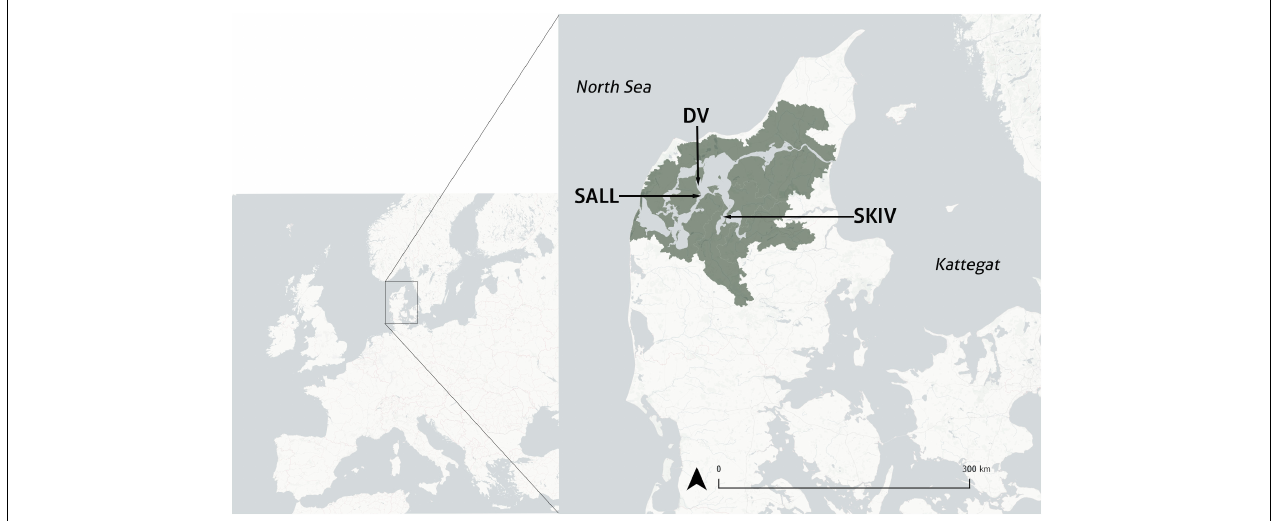
FIGURE 1 | Map of mainland Denmark and location of three study sites, inset to a map of Europe. Limfjorden catchment is illustrated in dark gray. SKIV, Skive Fjord site; DV, Dråby Vig site; SALL, Sallingsund